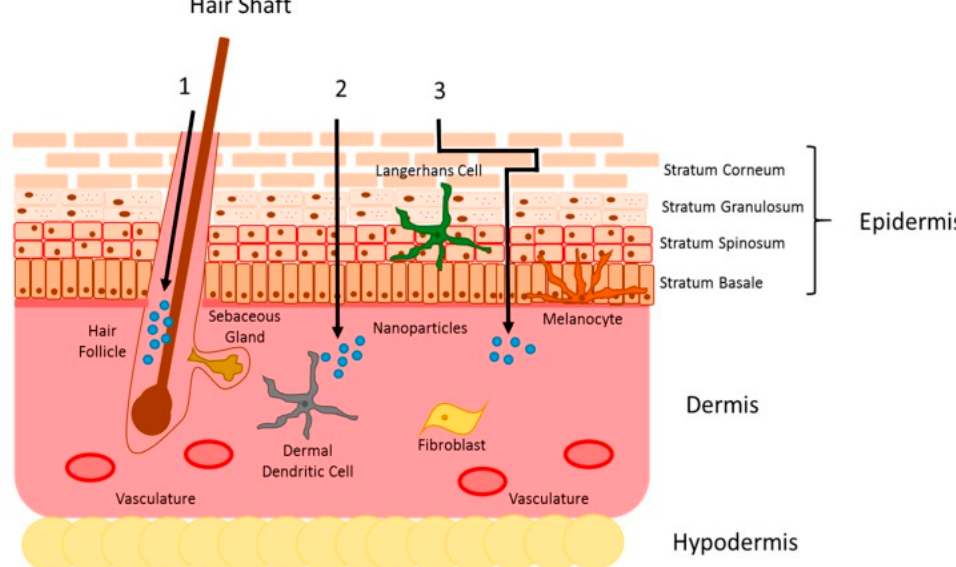
Figure 9. Representation of skin structures and drug penetration pathways. Topically applied drugs can penetrate the skin in one of three different ways: (1) through the appendageal route, (2) through the intracellular route or (3) through the intercellular route. Use authorized by Ref. [92].